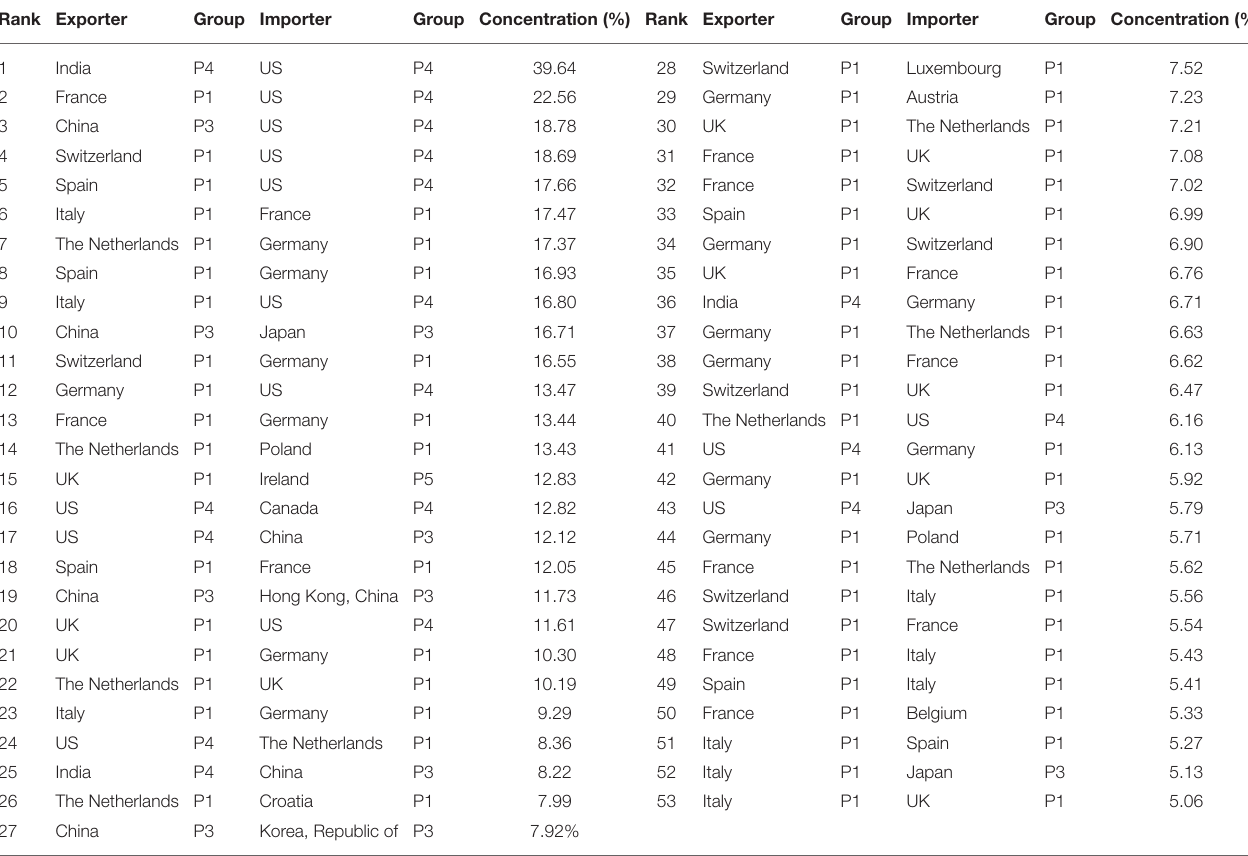
TABLE 4 | Co-opetition among major exporters of TCM products in